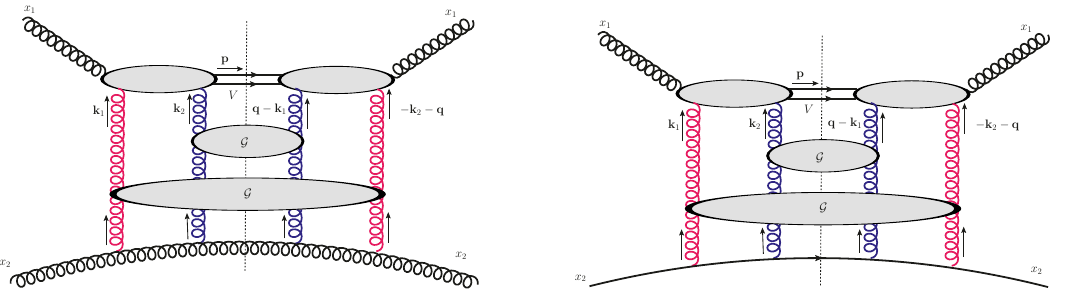
Figure 3 . Correlated contributions of 1 + 2 gluons fusion to hadroproduction cross section of a heavy vector meson V with partonic targets: a gluon (left) and a quark (right). The blobs with denote the BFKL gluon Green’s functions. The two BFKL Green’s functions are evolved G independently. Gluons 14 and 23 are projected onto color singlet